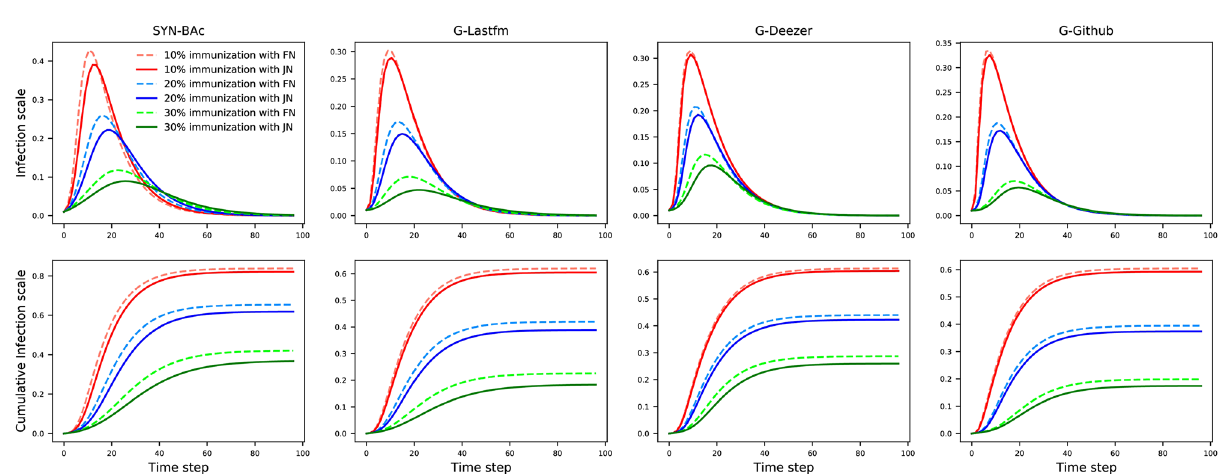
Figure 8. The infection scale (top row) and cumulative infection scale (bottom row) on four networks with different fractions of nodes removed under various strategies, where β = 1.5 , γ = 1 and p = 0.01 . In the top row, JN performs better than FN in all the fractions and all the datasets, since JN generates lower and postponed infection scale peaks compared to FN. With the increasing of the nodes removal fraction, the advantage of JN grows. In the bottom row, immunizing the same number of nodes identified by JN can reduce the network’s connectivity more than FN, resulting in a smaller final infection scale. For example, the final infection scale decreases from 40 to 32% when immunizing 30% nodes identified by JN compared with FN in SYN-BAc network. The results are averaged over 20 independent